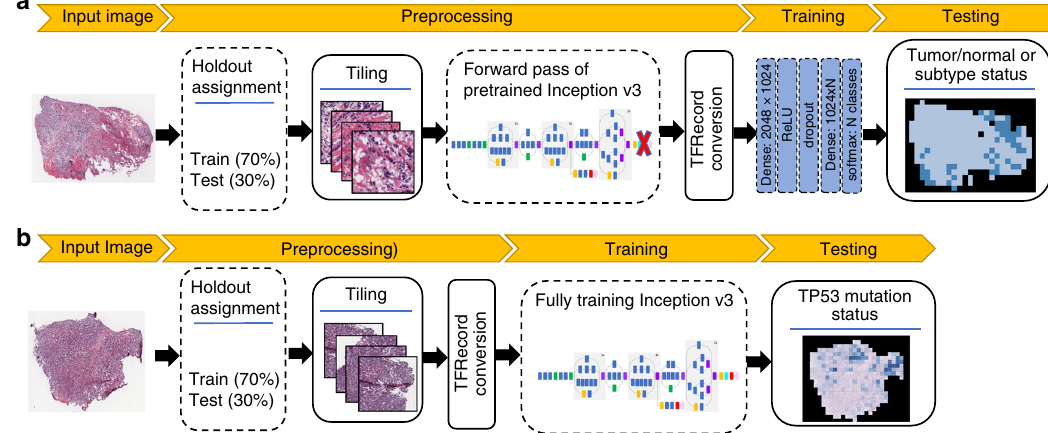
Fig. 1 Classi fi cation pipelines. a Transfer-learning pipeline for tumor/normal and subtype classi fi cation. b Full training pipeline for mutation classi fi cation.